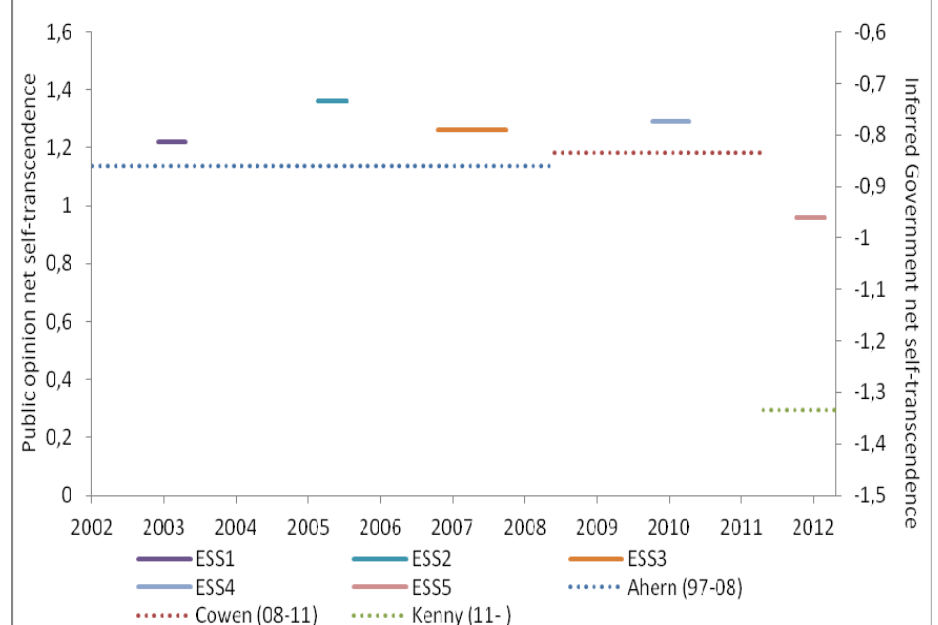
Figure 5: Net self-transcendence for